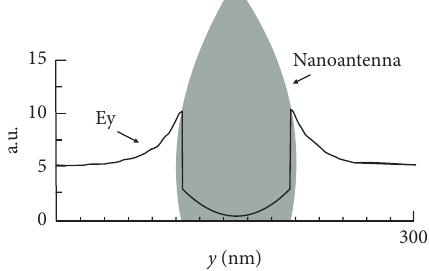
Figure 8: Electric field distribution near the nanoantenna for the CNV case and normal